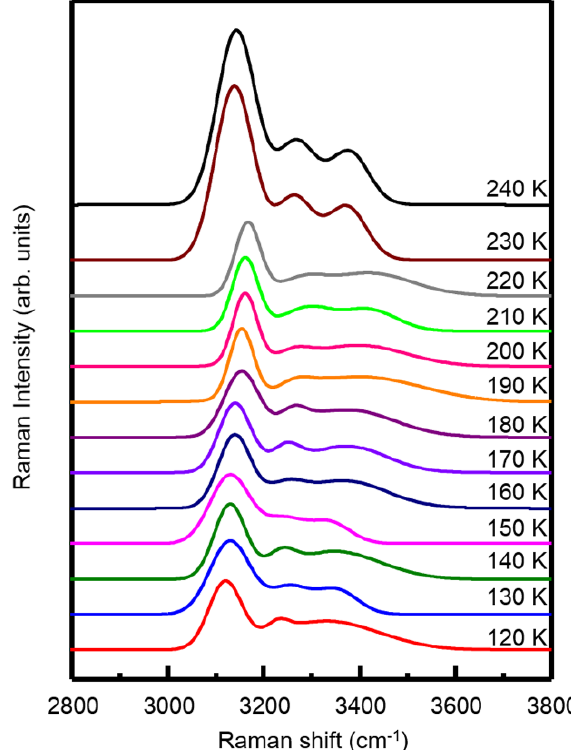
Figure 4. In situ Raman OH stretching spectral changes of the nanofibrous ice during the heating process from 120 K to 240